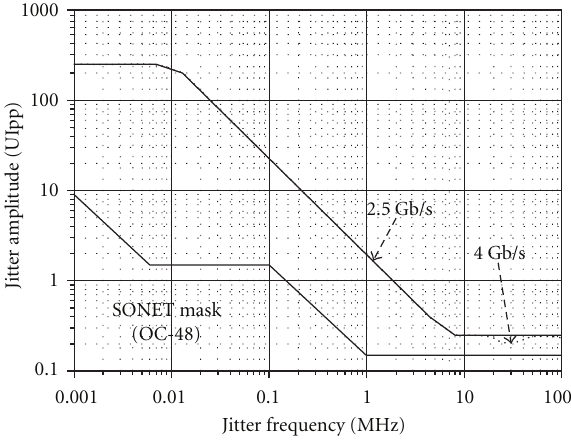
Figure 10: Measured jitter tolerance.